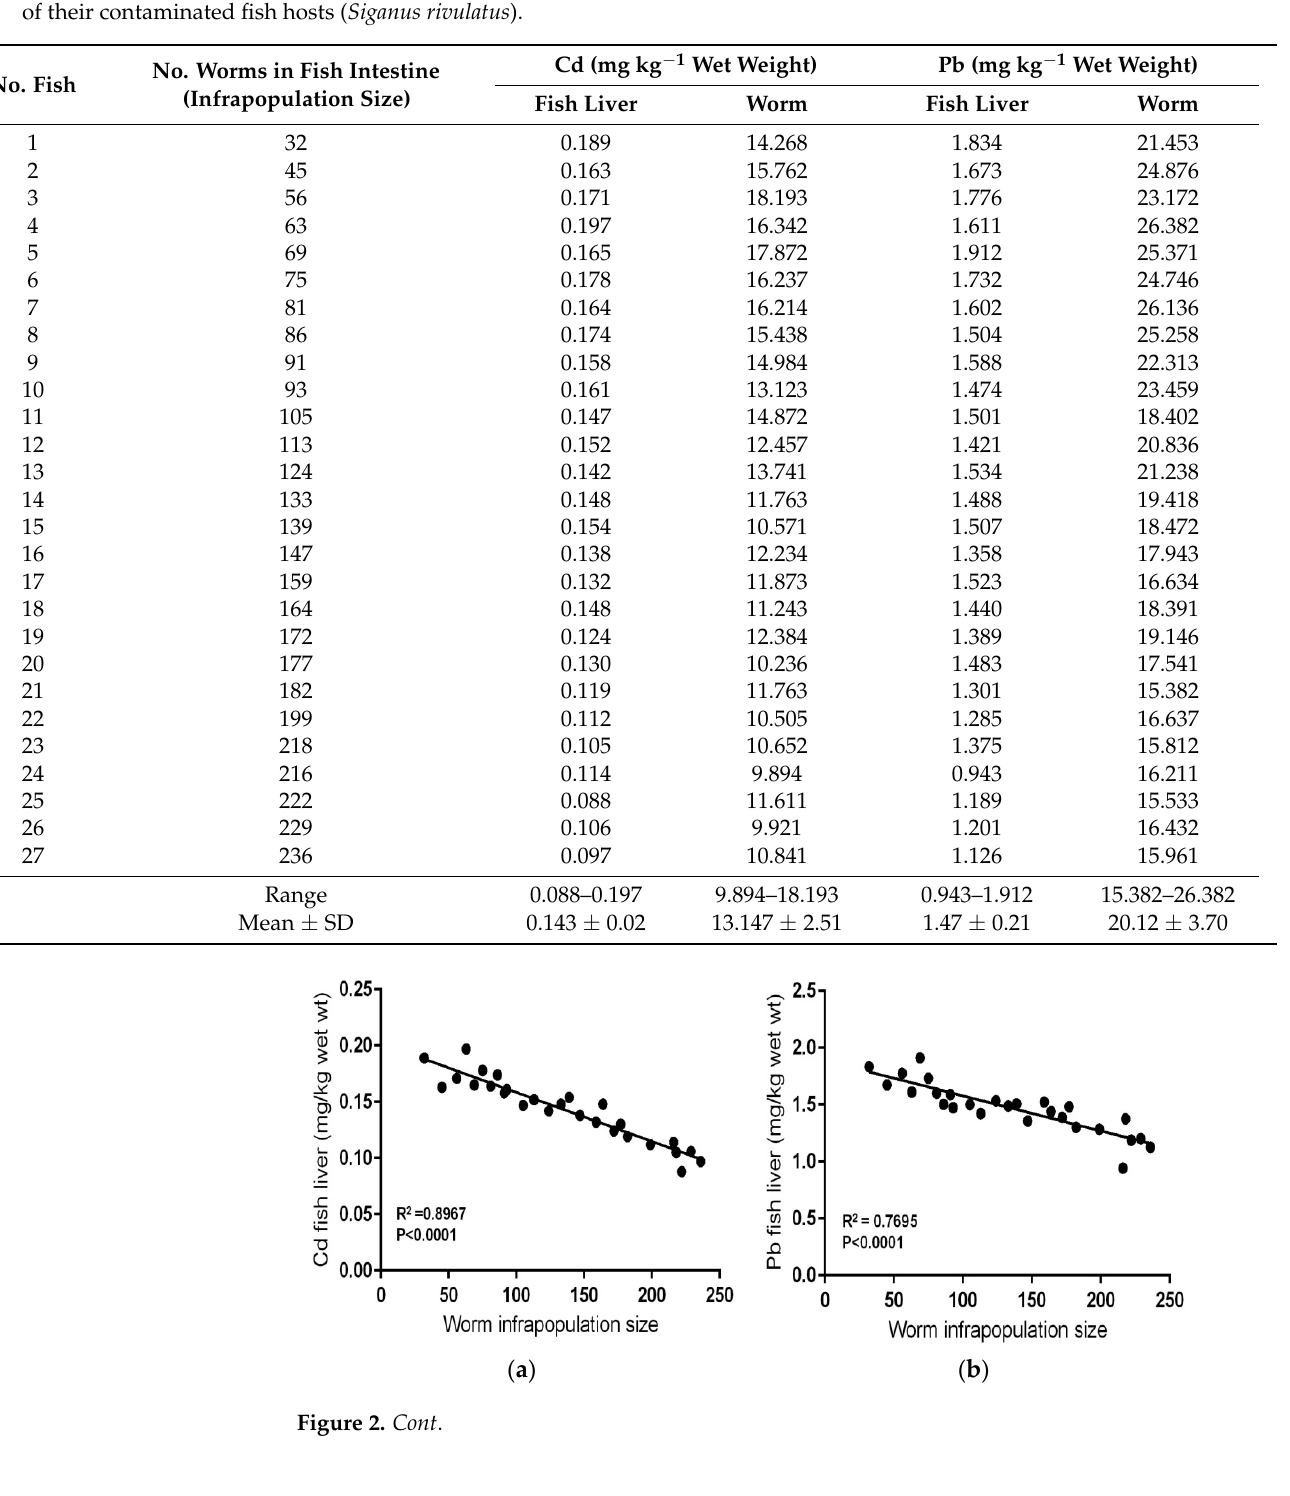
Table 4. Cadmium and Pb concentrations in 27 infrapopulations of the acanthocephalan worm S. rubrimaris and in the liver of their contaminated fish hosts ( Siganus rivulatus ).